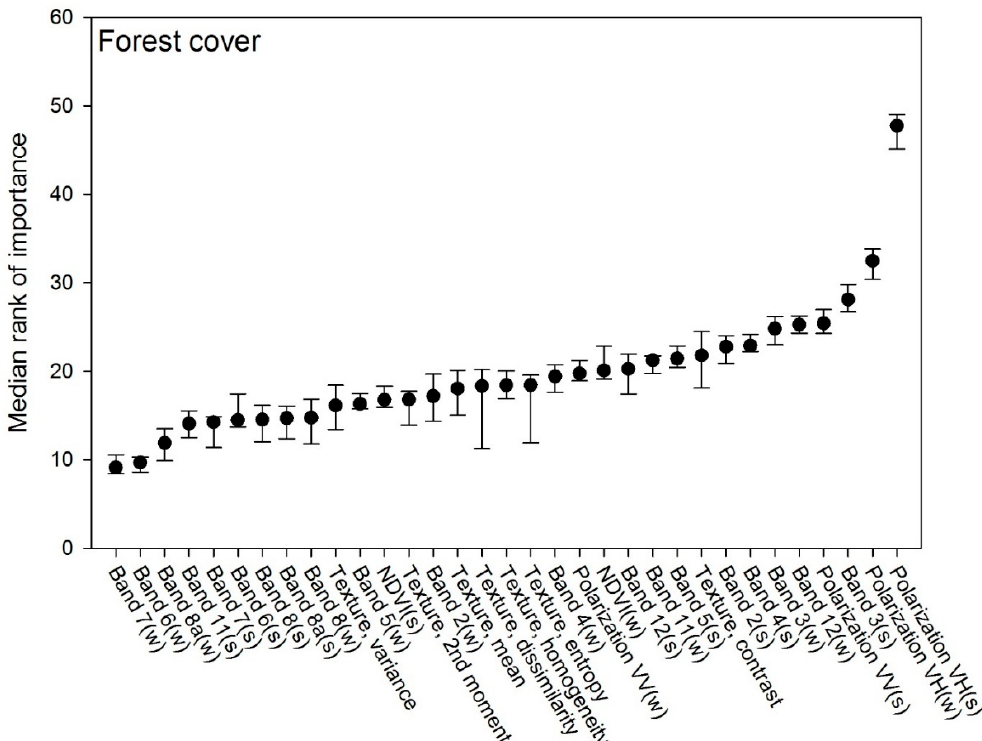
Figure 1. Input features for the classification of forest cover in Denmark 2018 ranked after importance in the Boruta simulations.